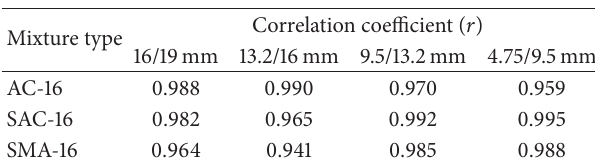
Table 5: Correlation analysis results between fractal dimension of coarse aggregates and high-temperature stability of asphalt mixtures.